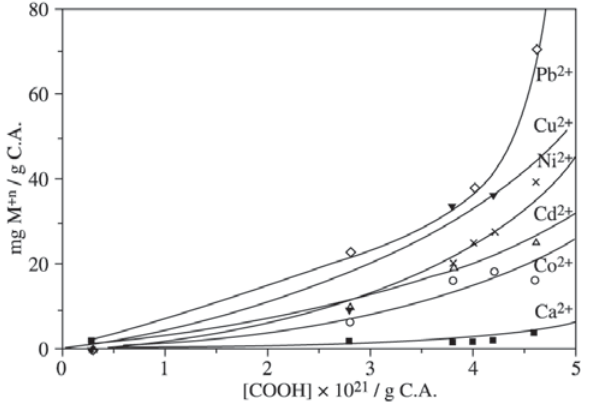
Figure 7. Metal cations adsorption on functionalized activated carbons.